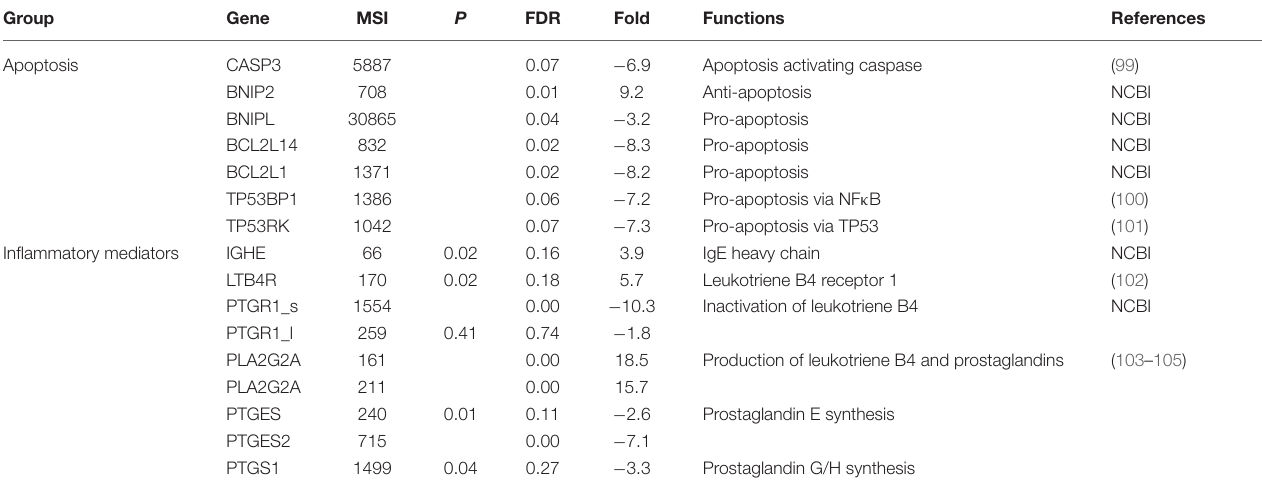
TABLE 7 | Mean expression levels (microarray signal intensity, MSI), false discovery rates (FDR) and fold differences ( + and – values as up- and down-regulated in carriers compared to non-carriers, respectively) of genes involved in apoptosis or inflammatory mediator production. Group Functions